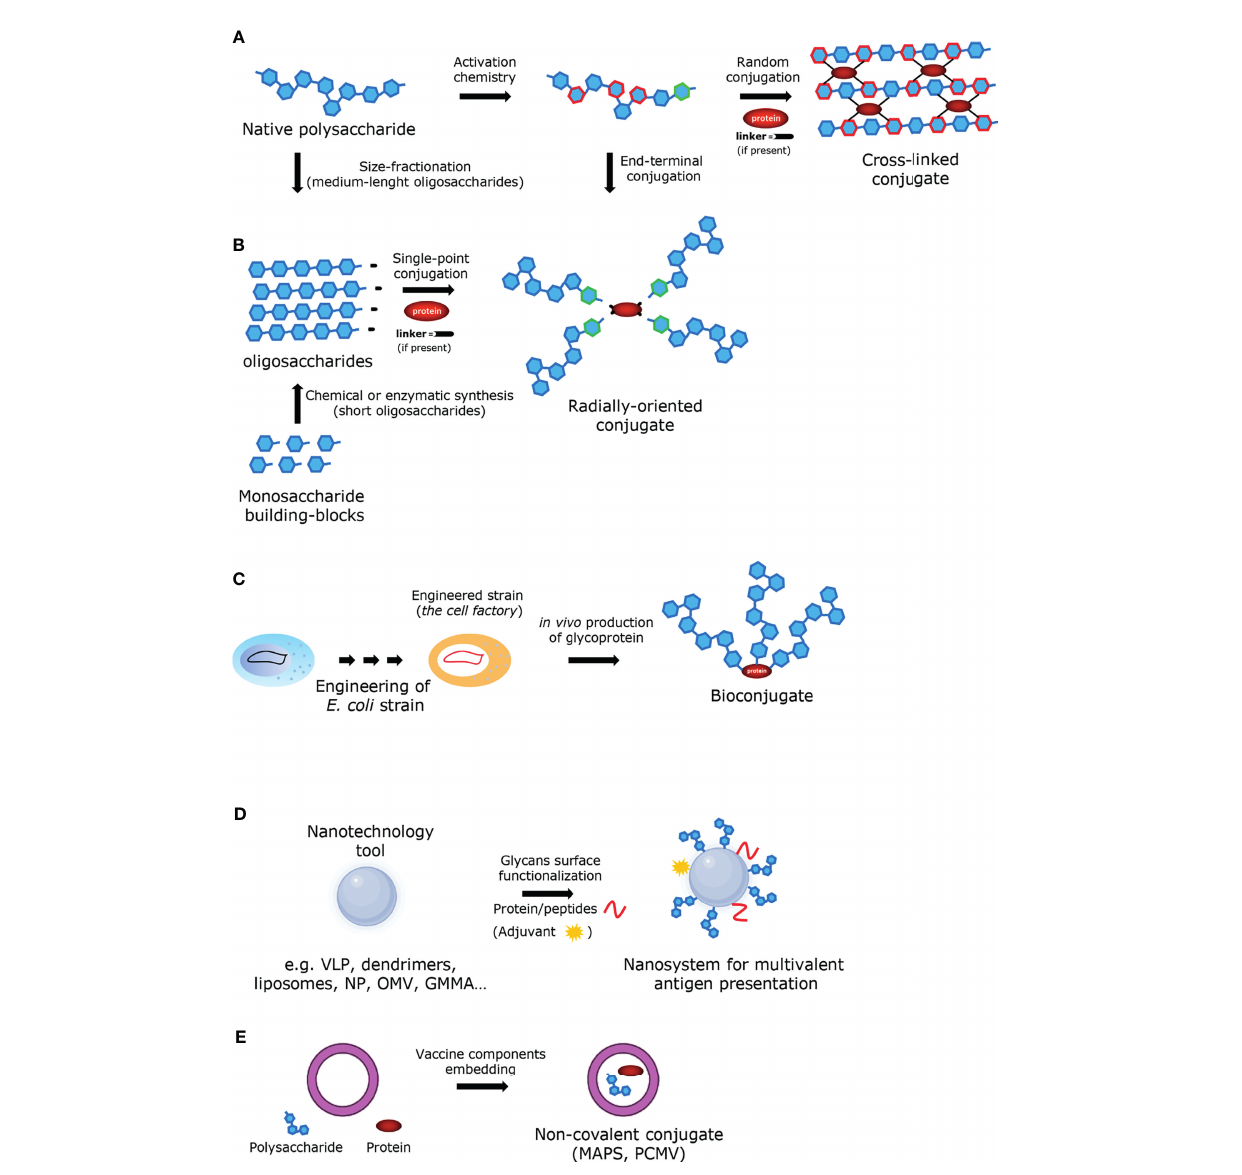
FIGURE 2 | Graphic illustration of the approaches employed for the construction of glycoconjugate vaccines (A) Glycoconjugate obtained by random conjugation of native polysaccharide. (B) Glycoconjugate obtained by end-terminal conjugation of oligosaccharides (produced either by size-fractionation of polysaccharide or by chemical/enzymatic synthesis). (C) Bioconjugate obtained in vivo from engineered E. coli strain. (D) Glycoconjugate obtained from nanotechnology tool. (E) Non- covalent conjugate obtained by entrapment of the vaccine